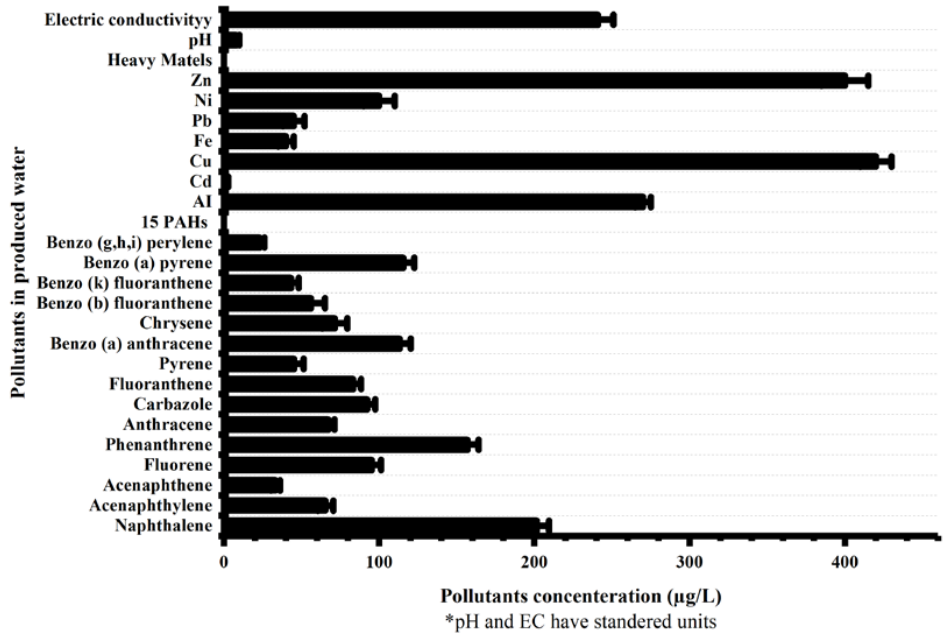
Figure 1. Characterization of produced